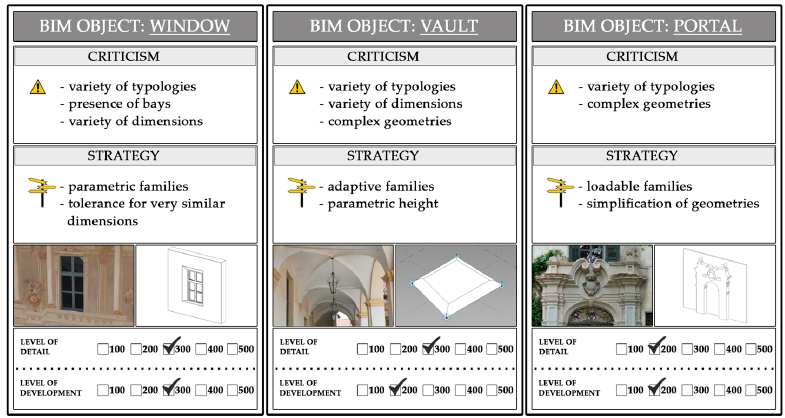
Figure 7. Different strategies adopted for architectural building information modeling (BIM) objects.